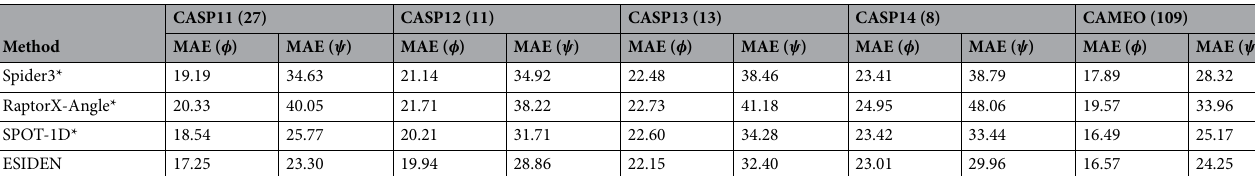
Table 4. Comparison among different methods on the TFM targets of the CASP11, CASP12, CASP13, CASP14, and CAMEO. *The results are obtained locally using the Spider3, RaptorX-Angle, and SPOT-1D standalone packages,